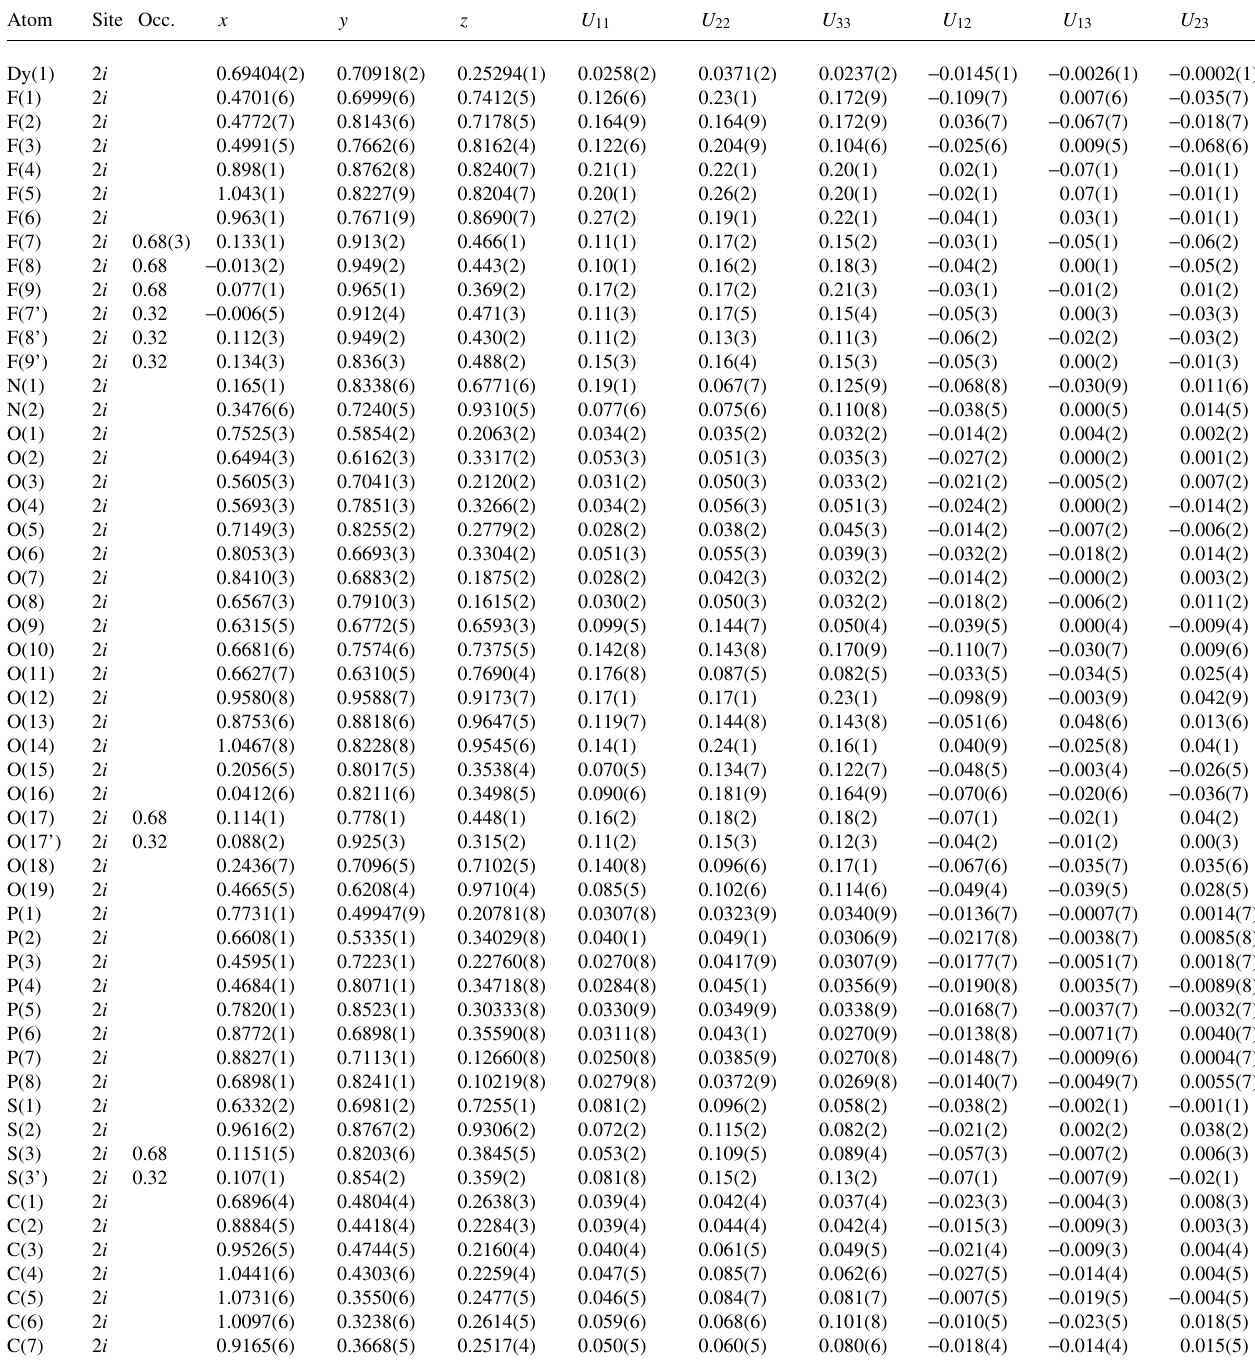
Table 3. Atomic coordinates and displacement parameters (in Å 2 )